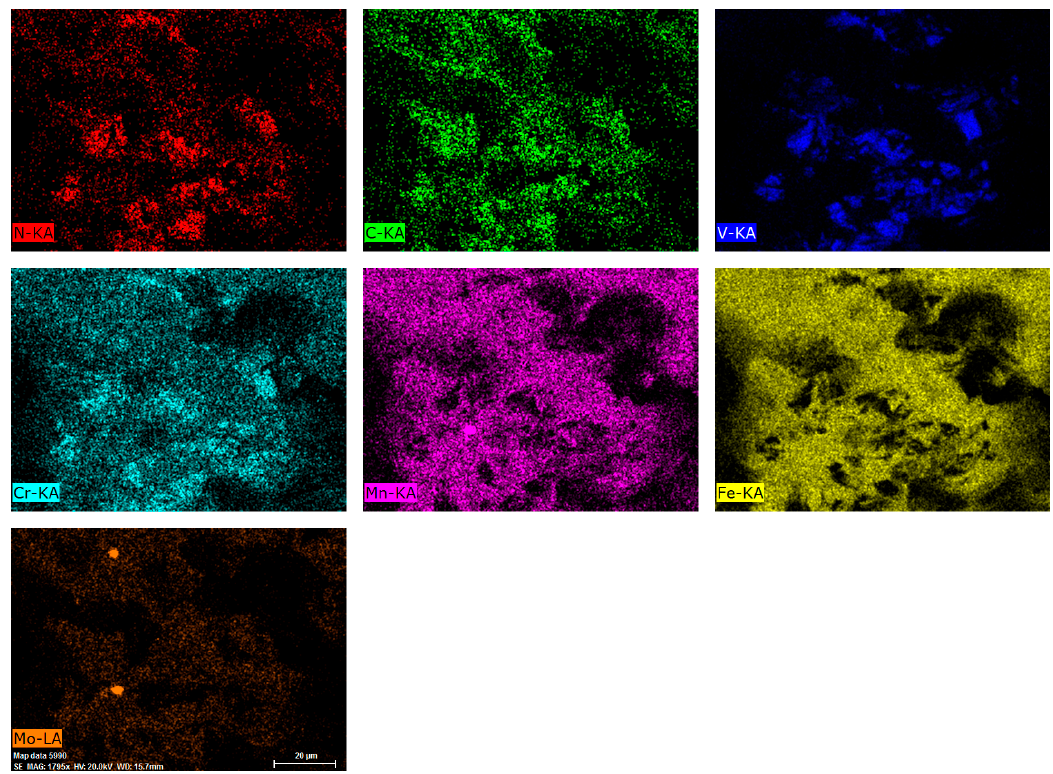
Figure 14. Energy ‐ dispersive X ‐ ray spectrometer (EDS) element mappings of S ‐ 760 fractograph, Figure 14. Energy-dispersive X-ray spectrometer (EDS) element mappings of S-760 fractograph, scale scale bar: 20 μ m. bar: 20 µ